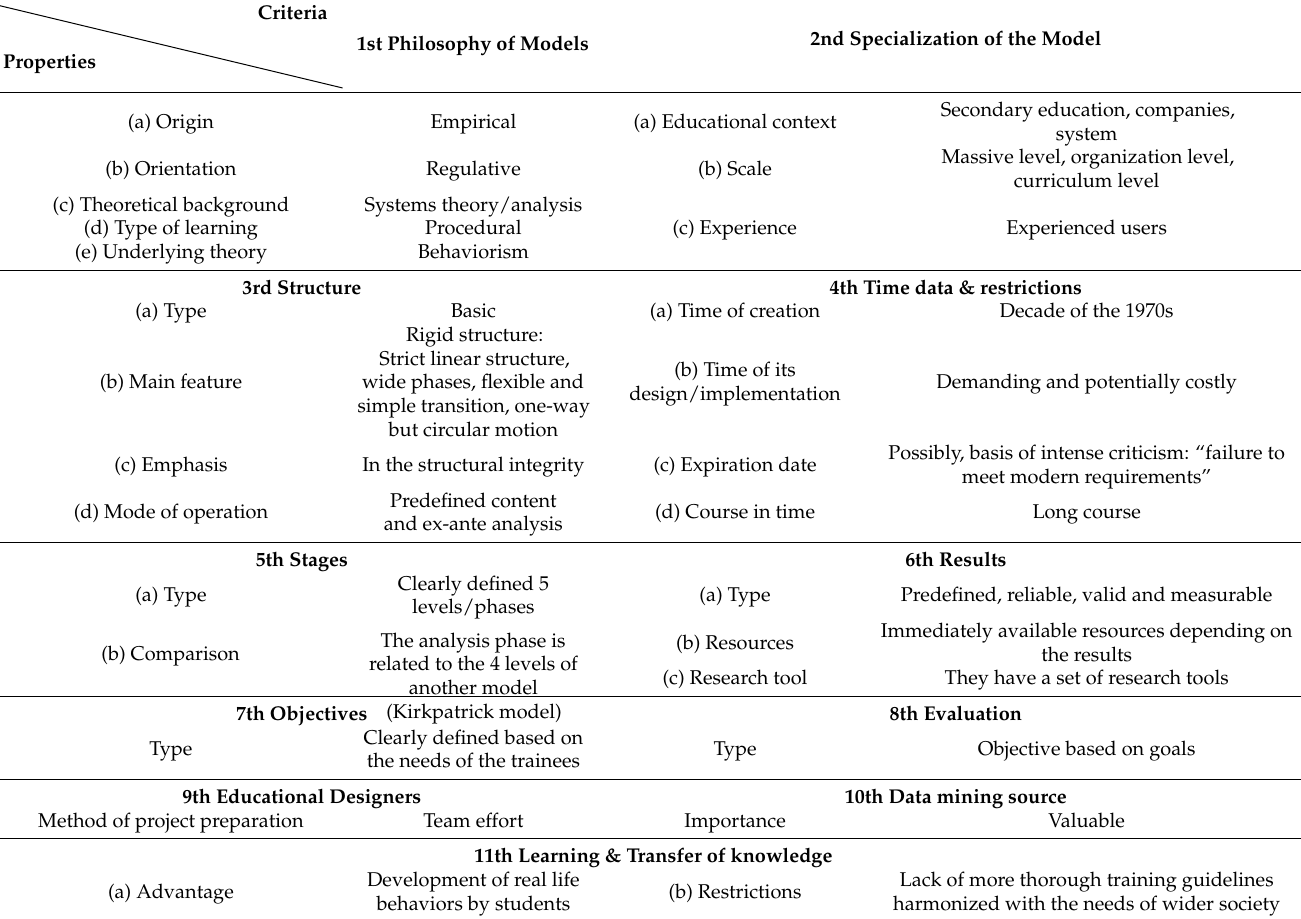
Table 1. Characteristics of the ADDIE instructional design